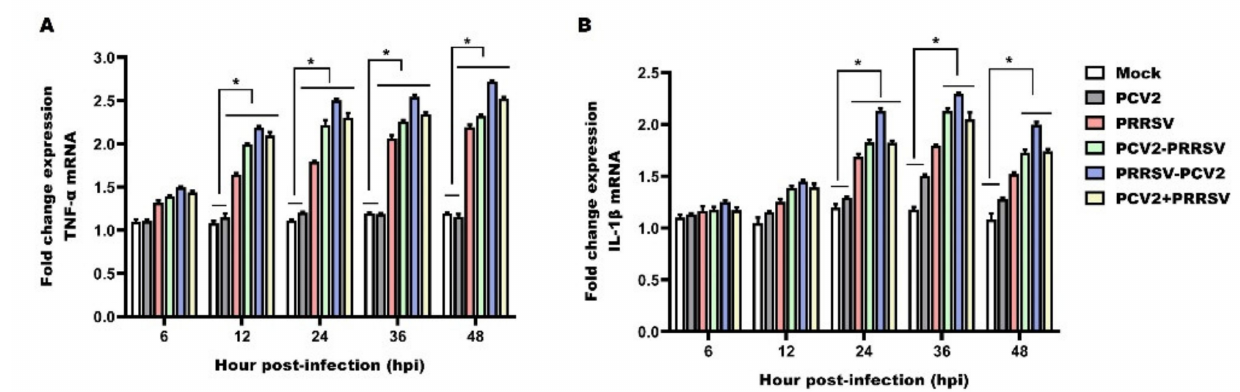
Figure 5. Relative mRNA expression of TNF- α and IL-1 β . PAMs in the PCV2 alone group (PCV2), the PRRSV alone group (PRRSV) and the PCV2 and PRRSV co-infected groups (PCV2–PRRSV, PRRSV– PCV2 and PCV2 + PRRSV) were inoculated with PRRSV or/and PCV2 at a MOI of 1, respectively. PAMs in the mock group were inoculated with equal RPMI-1640 medium. Then, PAMs from these groups were collected at 6 h, 12 h, 24 h, 36 h and 48 h post-infection, respectively. RT-qPCR analysis of TNF- α ( A ) and IL-1 β ( B ) mRNAs in PAMs with different groups. Data are expressed as means ± SD of three independent experiments. Significant differences between groups are represented (* p <